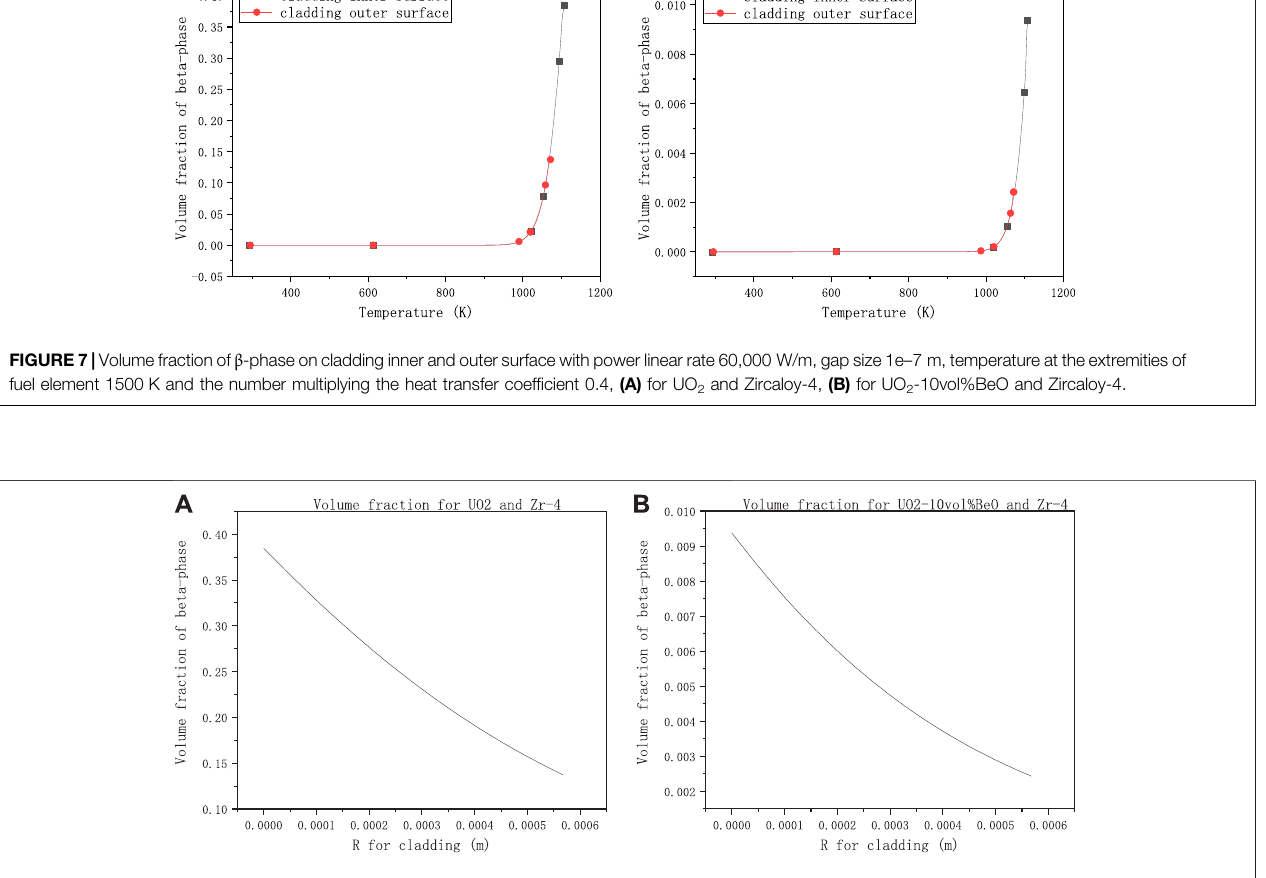
FIGURE 8 | Volume fraction of β -phase from cladding inner surface to outer-surface with the same parameter setting in Figure 7 for (A) UO 2 and Zircaloy-4, (B) UO 2 -10vol%BeO and